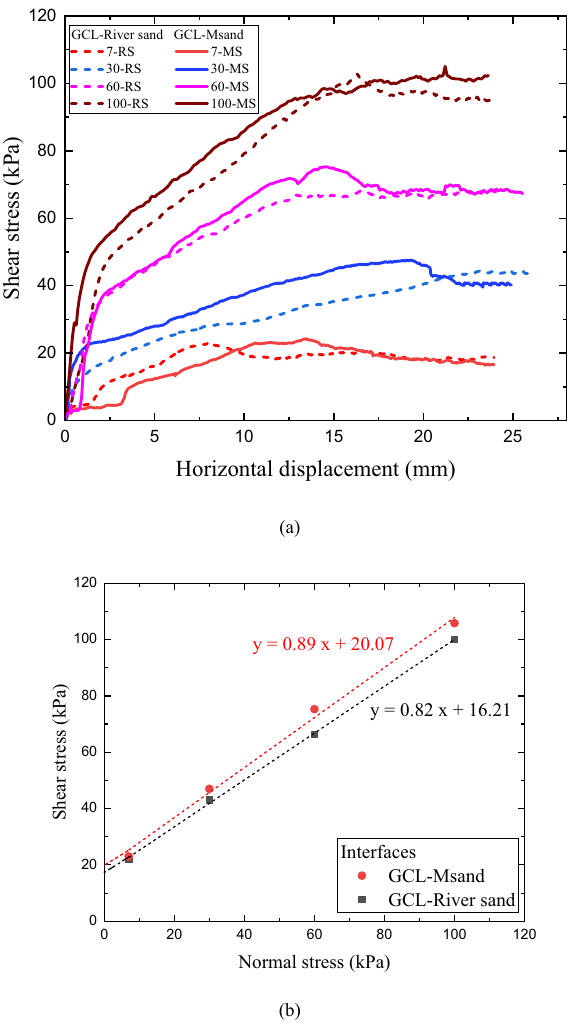
Figure 6. Shear response of GCL- sand interfaces under dry condition ( a ) stress–displacement response, ( b ) failure